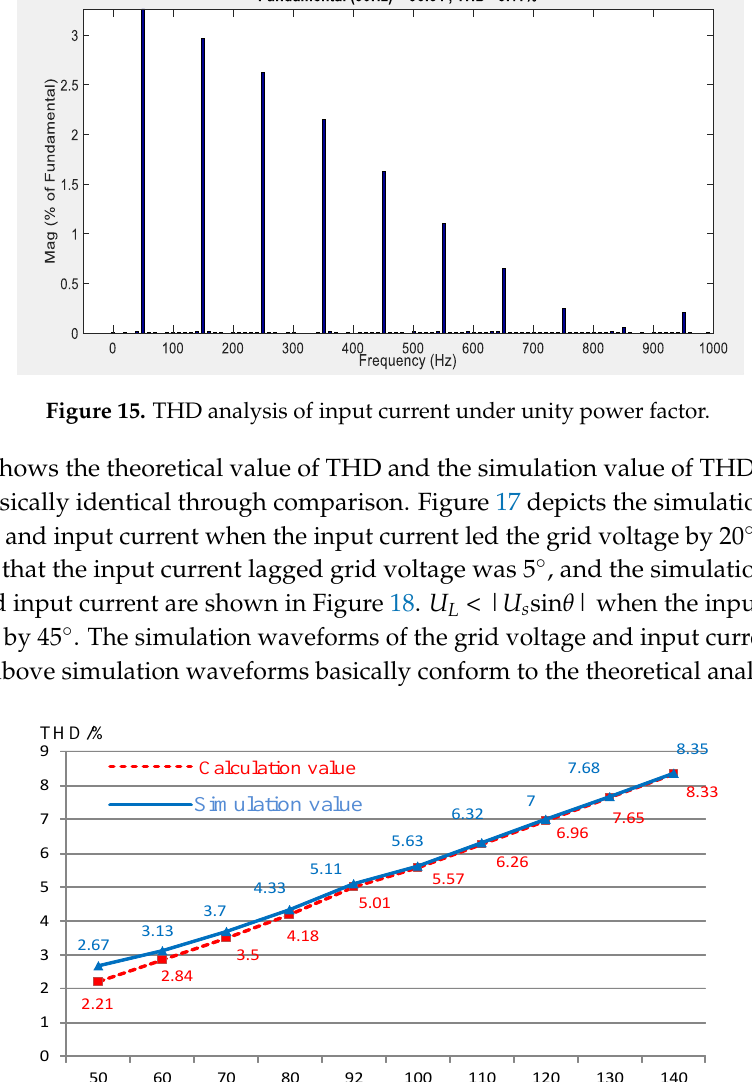
Figure 14. Simulation waveforms of grid voltage and input current under unity power factor. Energies 2018 , 11 , x